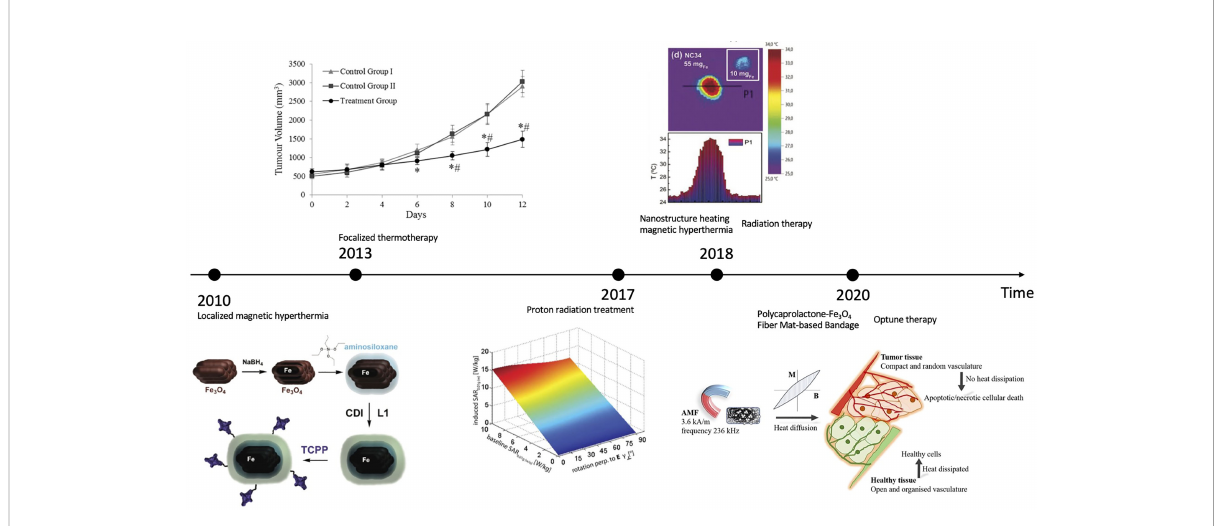
FIGURE 1 Schematic representation of EMF ’ s in fl uence on clinical therapies: a chronological comparison (2010-2020). CREDIT: Bibliography 46 – 52. For (46): Reprinted (adapted) with permission from {Rachakatla RS, Balivada S, Seo G-M, Myers CB, Wang H, Samarakoon TN, et al. Attenuation of mouse melanoma by A/C magnetic fi eld after delivery of bi- magnetic nanoparticles by neural progenitor cells. ACS nano. (2010) 4(12):7093 – 104. doi: 10.1021/nn100870z}. Copyright {2010} American Chemical